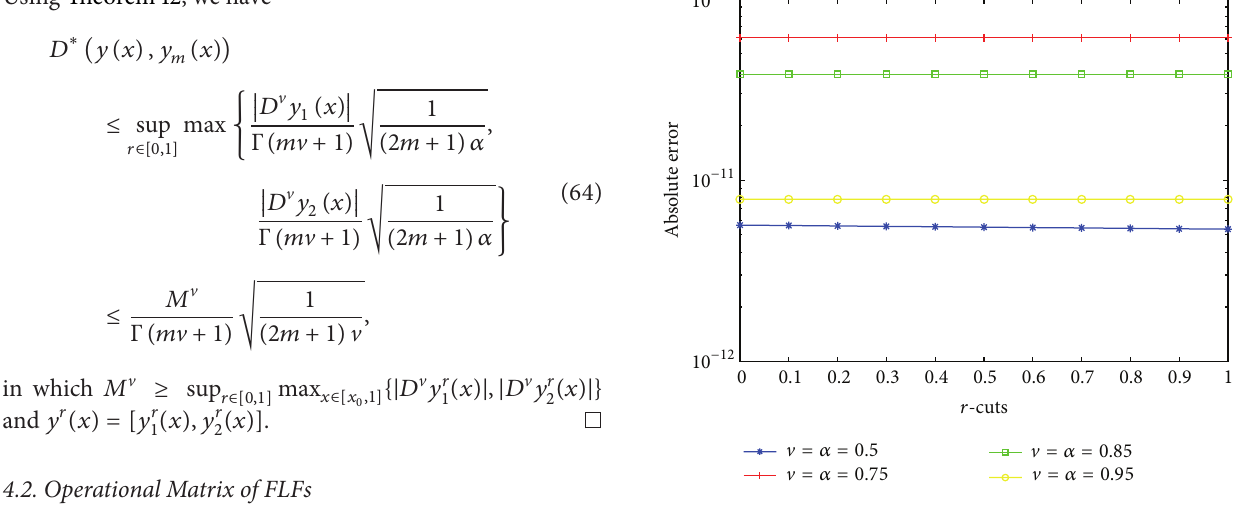
Figure 4: The absolute error for different values V = 𝛼 with 𝑚 = 12 , = 0.012 , and 𝑘 = 0.001 . 𝑘 1 2